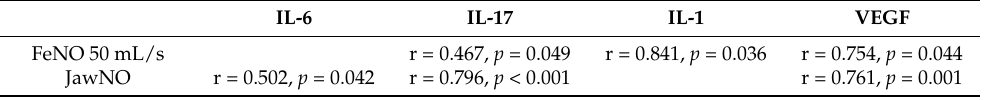
Table 4. Correlations between EBC cytokines and NO production (FeNO 50 mL/s and JawNO) in NSCLC